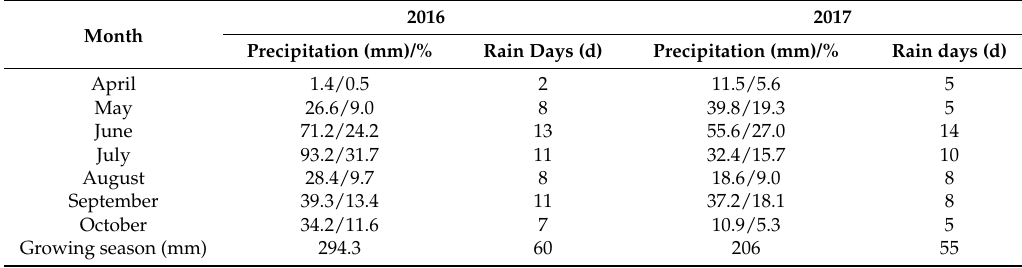
Table 1. Precipitation and the number of rain days during the growing season in different precipitation years.